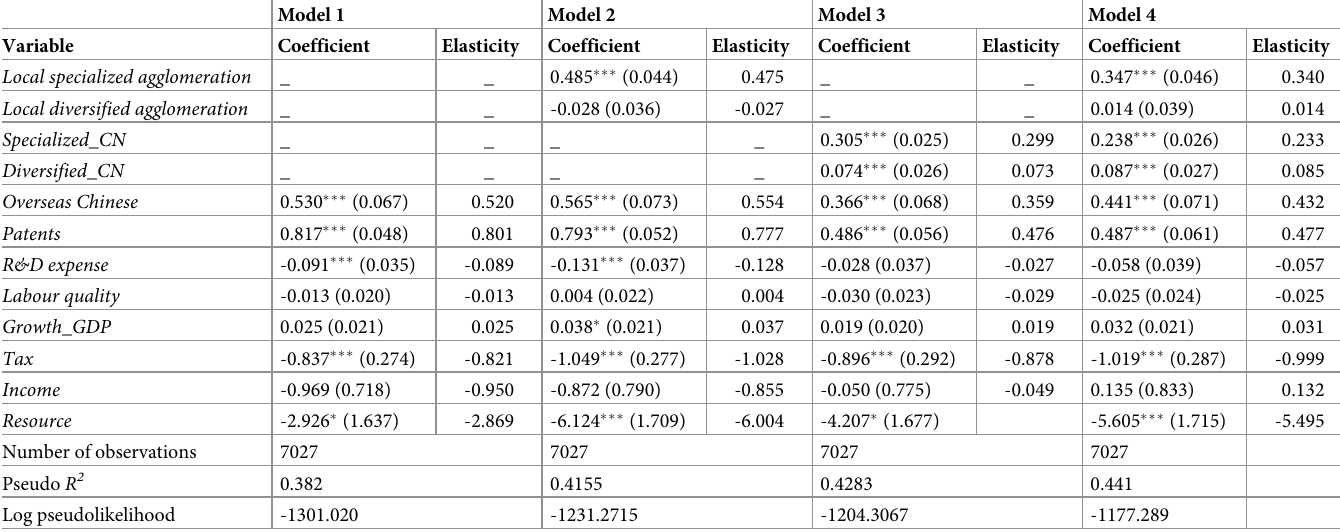
Table 4. Conditional logit estimation for CODI in the United